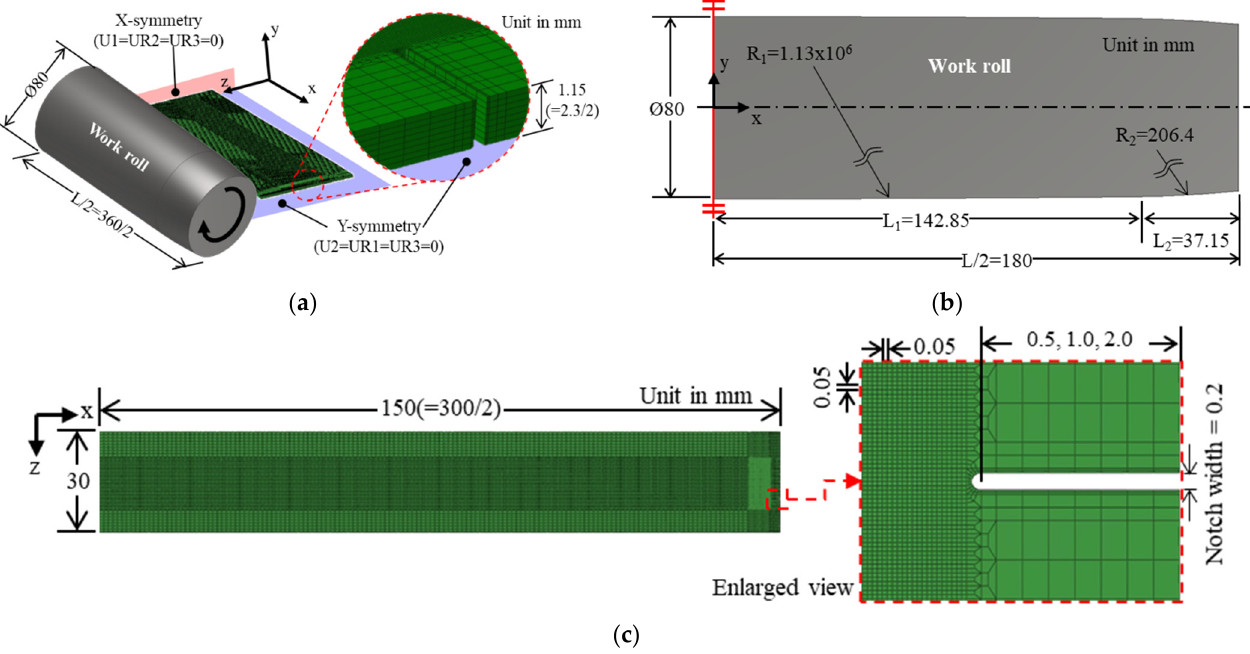
Figure 6. ( a ) Half symmetric model of work roll, quarter-symmetric model of strip and boundary conditions. ( b ) Half symmetric work roll with two radius of curvature emulating positive roll bending when viewed from the rolling direction (z-axis); ( c ) Local mesh refinement near the notch tip.